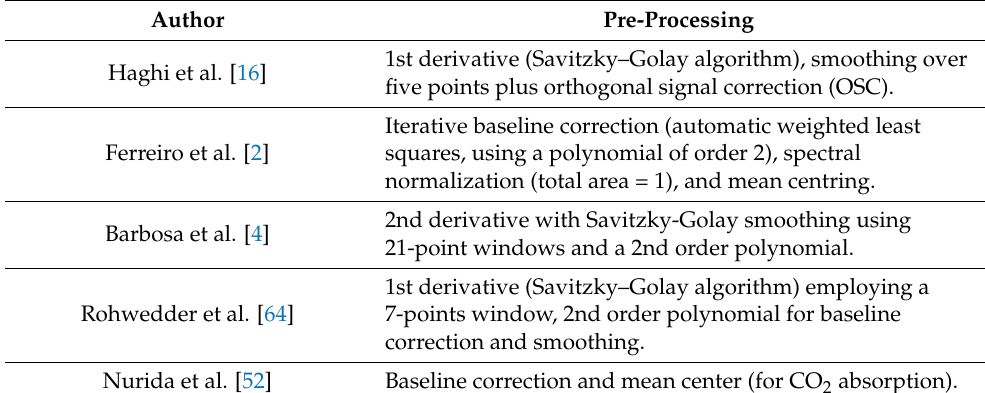
Table 3. Pre-processing options used by several authors before LNG multivariate